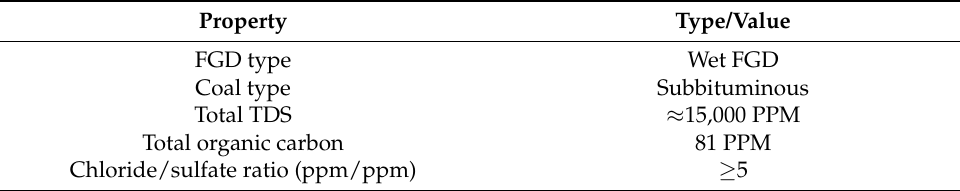
Table 1. The FGD WW Characterization.